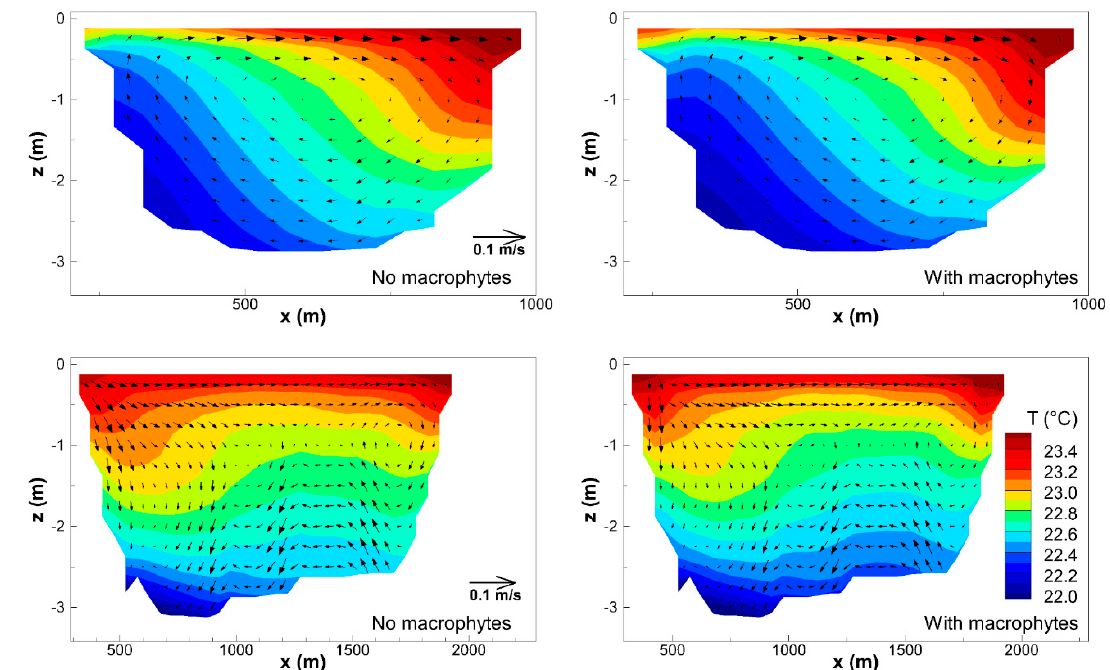
Figure 8. Modelled temperature fields and velocity circulation patterns of a cross section following ( upper panel ), and perpendicular to ( lower panel ), the wind direction without and with littoral macrophytes. The upper panel is the cross section along x = 1250 m and the lower panel is the cross section along y = 500 m, which are marked by the dashed lines in Figure 7.